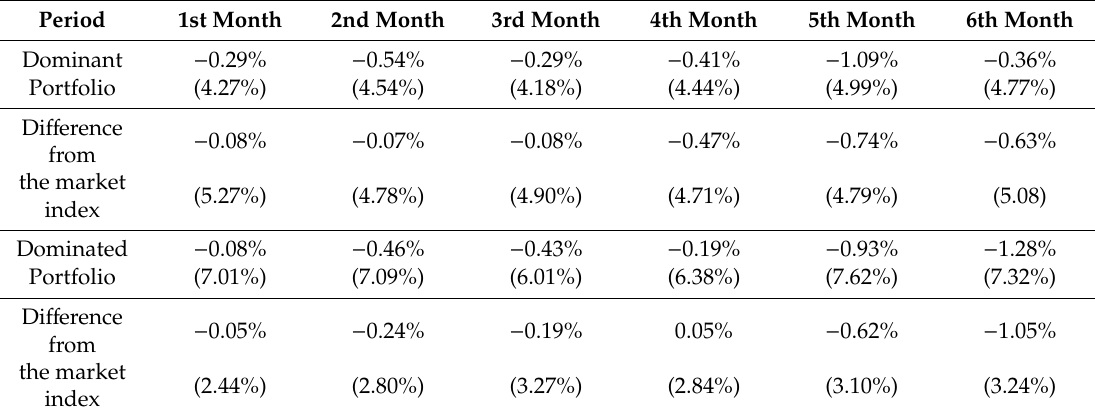
Table 4. Dominant and dominated portfolio returns after